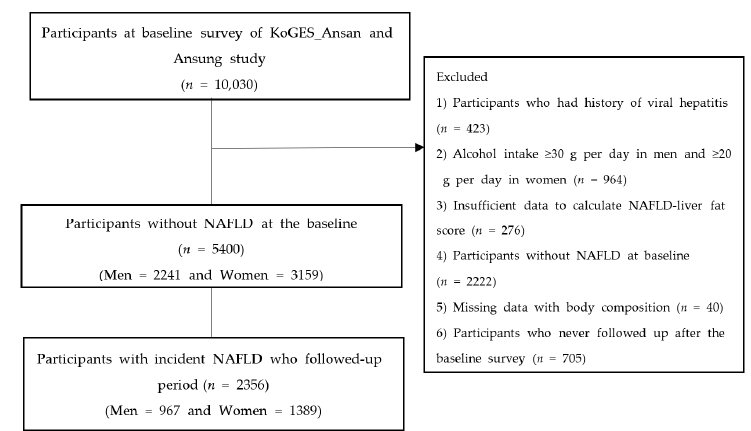
Figure 1. Flow chart of the study population .